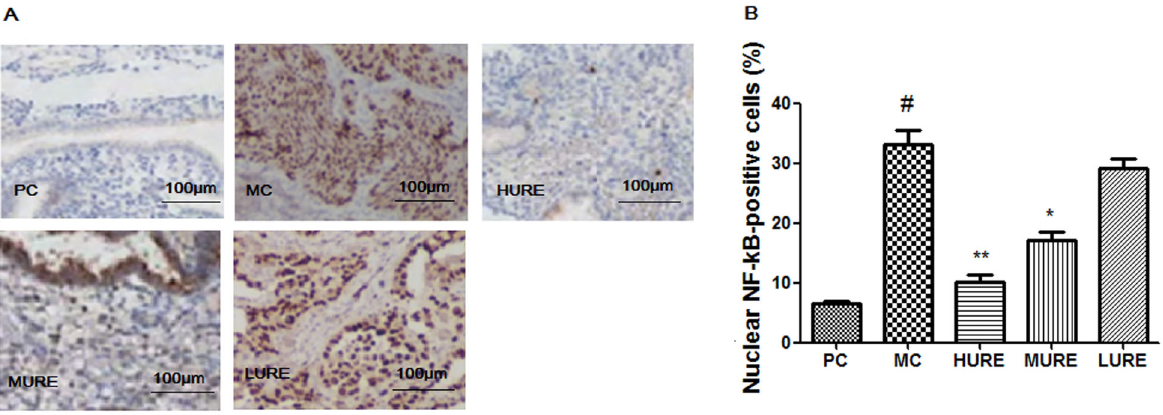
Figure 8. Uncaria rhynchophylla alkaloid extract (URE) suppressed the lipopolysaccharide (LPS)-induced activation of NF- k B p65 in the placenta tissue. Immunohistochemical staining of placental tissues ( A ). Original magni fi cation: (cid:1) 100; scale bar=100 m m. B , Percentage of nuclear NF-kB-positive cells in placenta tissue. Data are reported as means ± SE (n=8/group). # P o 0.01 vs PC group, *P o 0.05 and **P o 0.01 vs MC group (ANOVA). PC: pregnant control group; MC: LPS-treated group; HURE: LPS plus high-dose URE; MURE: LPS plus medium-dose URE; LURE: LPS plus low-dose URE.